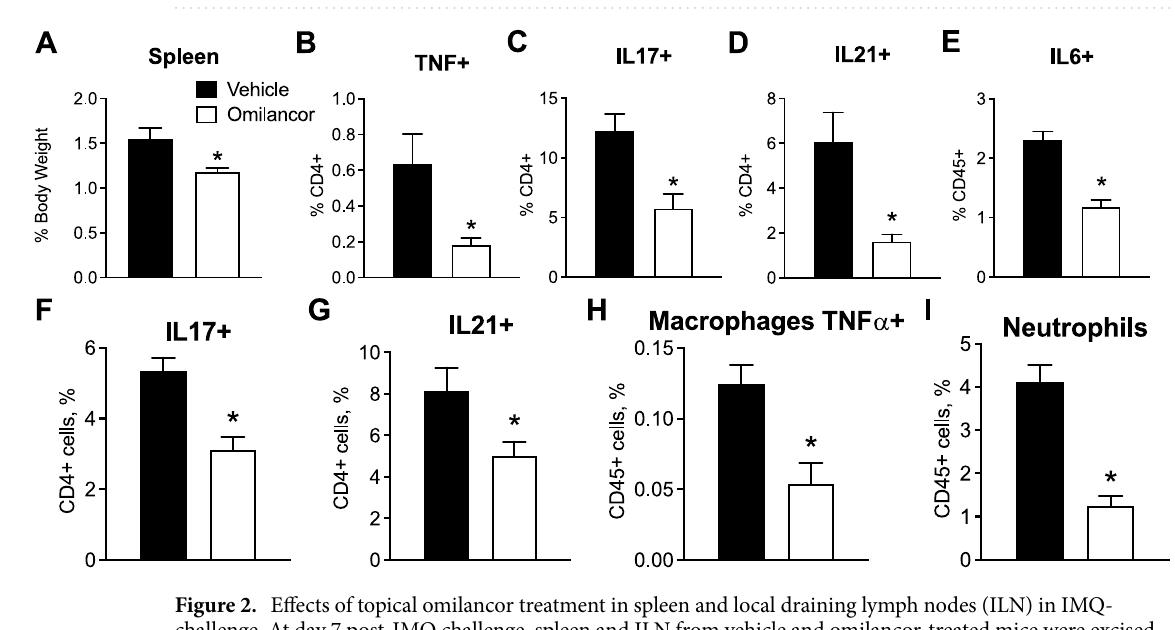
Figure 2. Effects of topical omilancor treatment in spleen and local draining lymph nodes (ILN) in IMQ- challenge. At day 7 post-IMQ challenge, spleen and ILN from vehicle and omilancor-treated mice were excised and single cell suspension isolated. Spleen size ( A ), represented as proportion of total body weight. Using flow cytometry, percentage of TNF+ ( B ), IL-17+ ( C ) and IL-21+ ( D ) CD4+ T cells, and IL-6+ ( E ) CD45+ cells was assessed in spleen. In draining ILNs, IL-17+ ( F ) and IL-21+ ( G ) CD4+ T cells, as well as TNFα-producing macrophages ( H ) and neutrophils ( I ) were also quantified using flow cytometry analysis. * P ≤